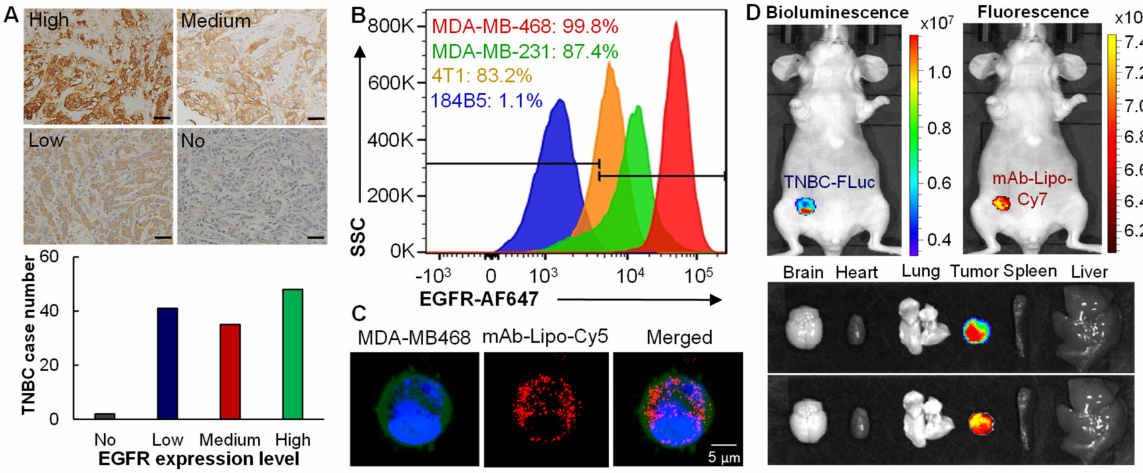
Figure 3. TNBC targeting by anti-EGFR mAb and mAb-Lipo. ( A ) The representative images of IHC staining to analyze the EGFR expression in TNBC patient tissue microarray. n = 126. Scale bar equals 50 µ m. ( B ) Flow cytometry analysis showing that EGFR mAb has high surface binding rate to TNBC cells (MDA-MB-231 and MDA-MB-468) while low binding to normal breast cells (184B5). Cells were stained with 1 µ g of mAb-AF647 per million cells at room temperature for 30 min. ( C ) Live-cell microscopy imaging of EGFR mAb-Lipo-Cy5. Whole cell labeled with GFP (displayed as green), nucleus labeled with NucBlue (blue), and mAb-Lipo labeled with PE-Cy5 (red). Scale bar equals 5 µ m. ( D ) Live-animal IVIS imaging showing in vivo TNBC targeting by EGFR mAb-Lipo-Cy7 in MDA-MB-231-FLuc xenograft in NSG mice. Ex vivo images of tumor and important organs, including brain, heart, lung, spleen and liver, also confirmed tumor targeting of mAb. The mAb-Lipo-Cy7 was i.v. injected via tail vein ( n = 3), and IVIS images were taken at 24 h post